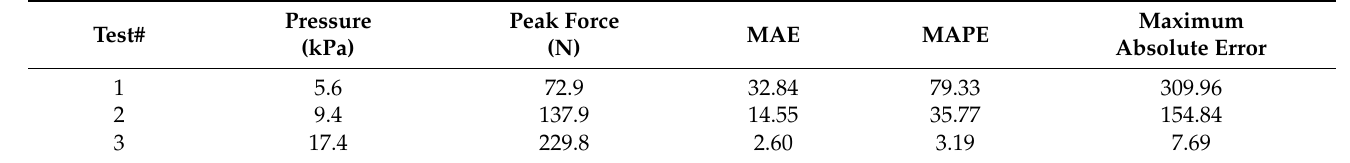
Figure 11. Test results of the actuators: ( a ) Comparison between the actuator without side supporting structure and the CFP-beamed actuator with a 3D-printed skeleton; ( b ) Comparison between PET-beamed actuator and CFP-beamed actuator; and ( c ) Comparison of the maximum output force of different actuators. Table 2. Summary of the test data of the actuator with a patched skeleton.